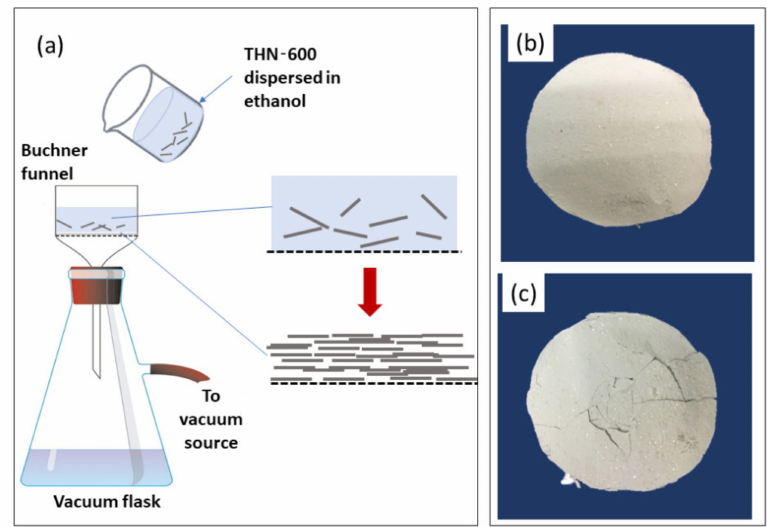
Figure 9. ( a ) Preparation of free-standing THN-600; ( b ) Synthesized FS-THN-50; ( c ) Synthesized